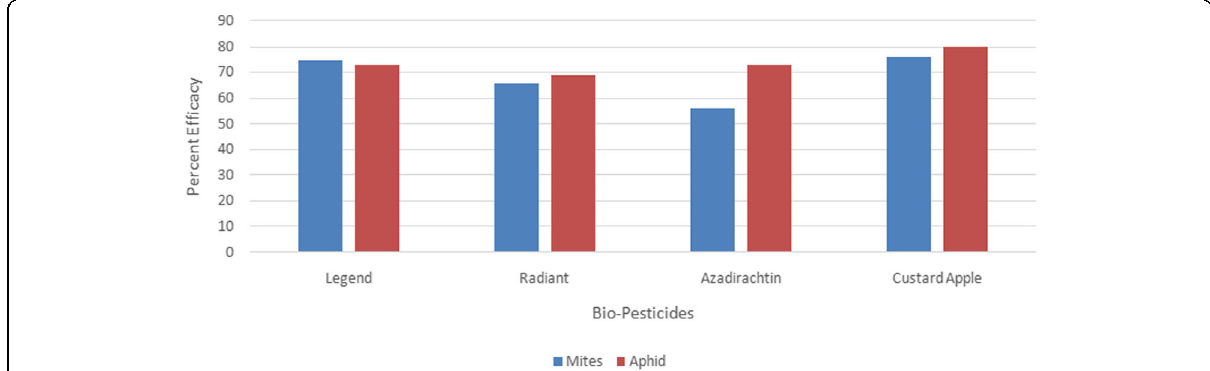
Fig. 3 The percent mortality of Tetranychus urticae at different days after spraying in the